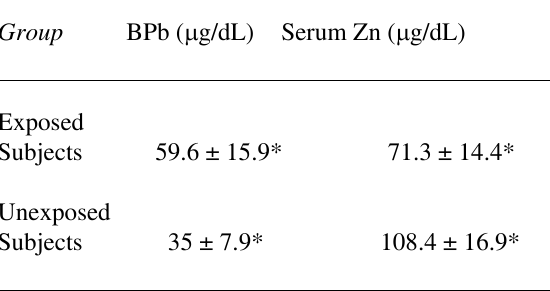
Table 3: Blood lead ( BPb) and serum zinc levels in exposed and unexposed subjects.